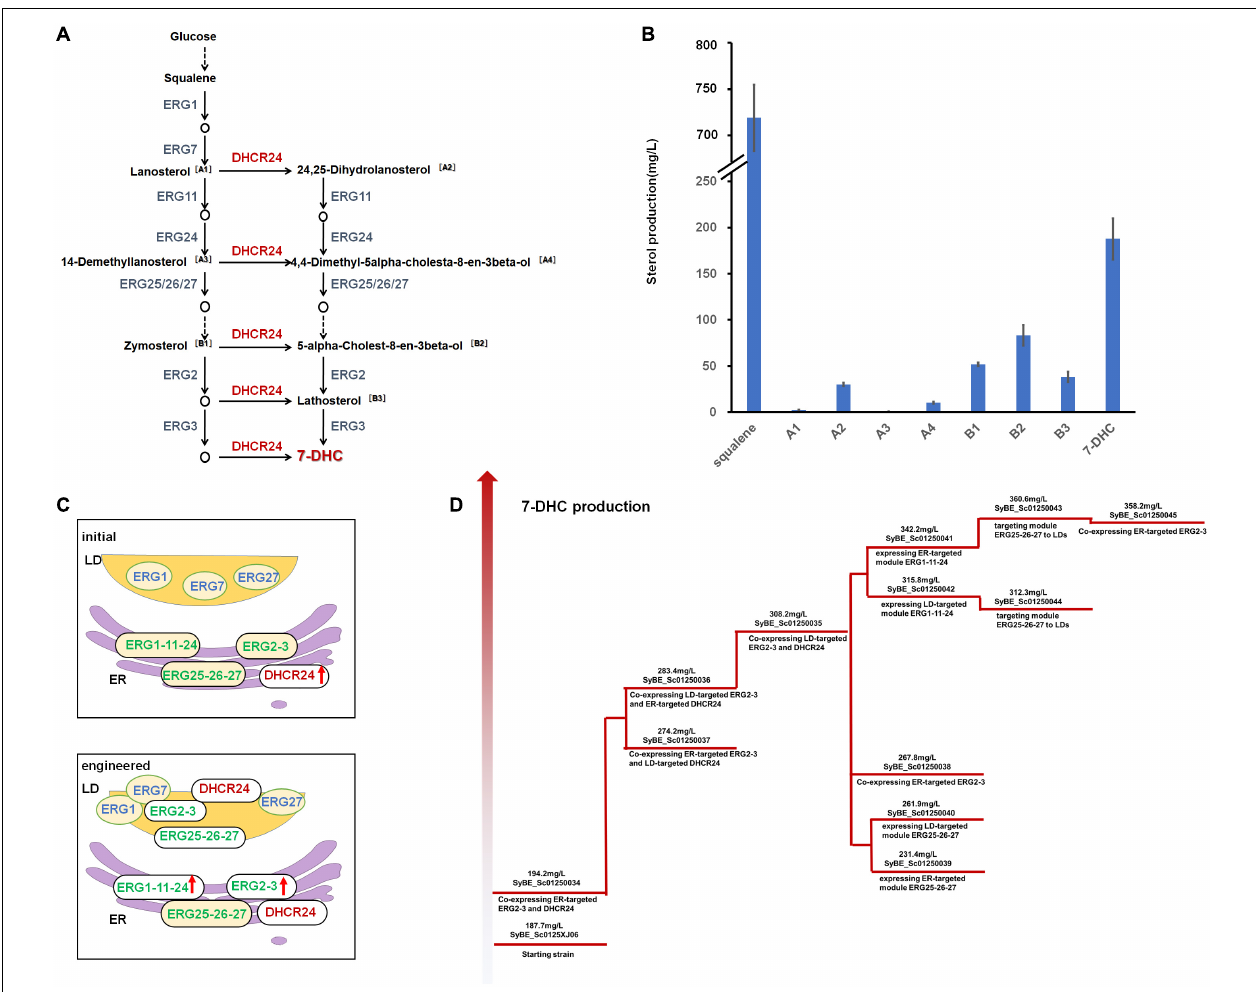
FIGURE 1 | The 7-dehydrocholesterol (7-DHC) biosynthesis pathway and the engineering strategies applied in this study. (A) The 7-DHC biosynthesis pathway in yeast. The code for each sterol intermediate is labeled beside the compound. Endogenous genes are in dark gray, and the heterologous gene is in red. (B) Metabolites of the post-squalene pathway accumulations in the control strain SyBE_Sc0125XJ06. (C) Schematic representation of the engineering strategies to enhance 7-DHC production in Saccharomyces cerevisiae . Enzyme distribution of the post-squalene pathway for the strain with the highest 7-DHC production in this study compared with the starting strain. LD-targeted or LD/ER dual localized endogenous enzymes of wild yeast are in blue; ER-targeted endogenous enzymes of wild yeast are in green; heterologous enzyme DHCR24 is in red. Backgrounds of the enzymes without modification are yellow. The up arrows represent protein overexpression. (D) Schematic representation of all the strains constructed in this study with their 7-DHC production and applied